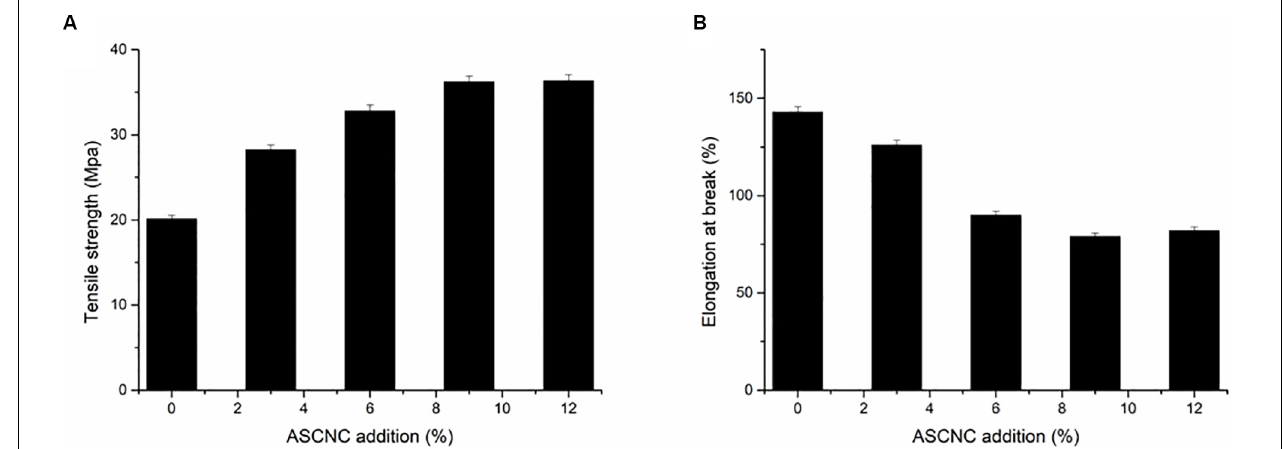
FIGURE 4 | Effect of ASCNC addition on mechanical properties of films. (A) Tensile strength; (B) elongation at break.